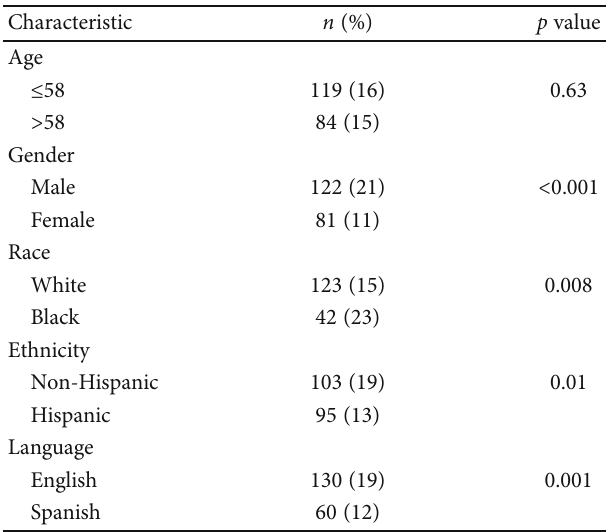
Table 2: Comparison of inadequate bowel prep (fair/poor) across patient demographic characteristics ( n = 1322 ).